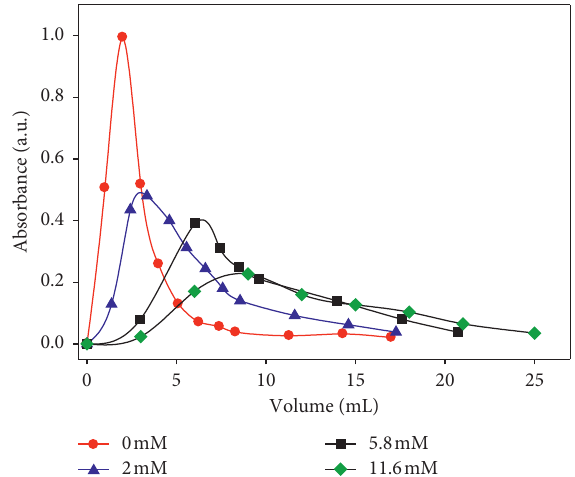
Figure 2: TAR elution profiles with eluent containing 2.5% ace- tonitrile at pH 3 with varied concentration of KH 2 PO 4 . TAR amount is 75 μ g.